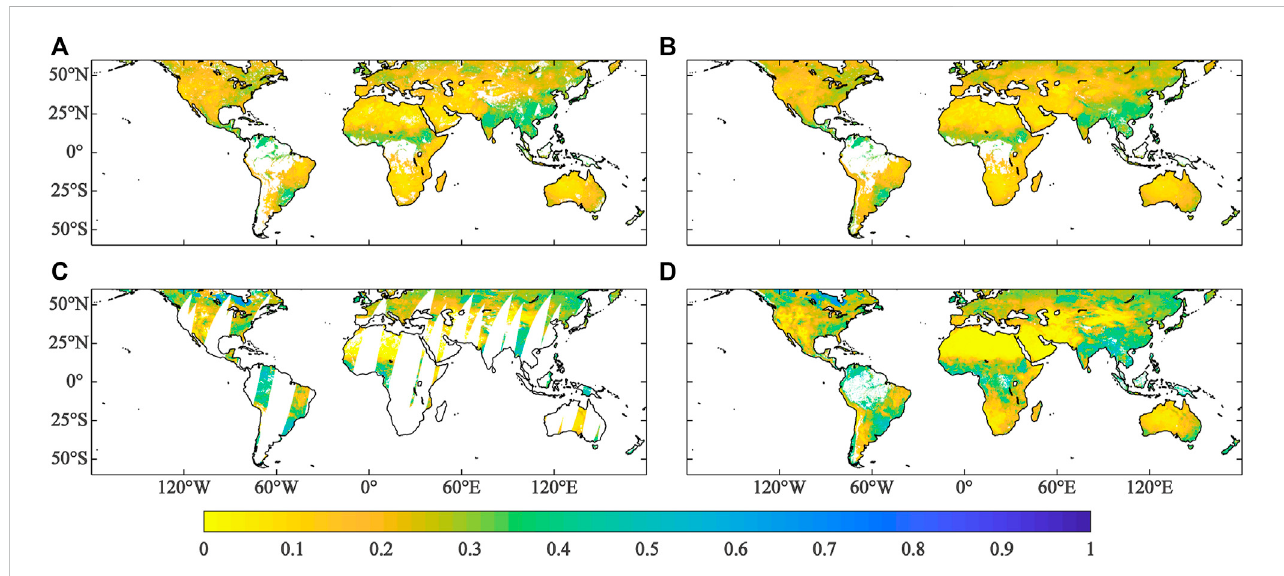
FIGURE 8 Spatial patterns of CCI ori (A) , CCI rec (B) , CM ori (C) , and CM rec (D) on 1 August 2012 (unit: m 3 /m 3